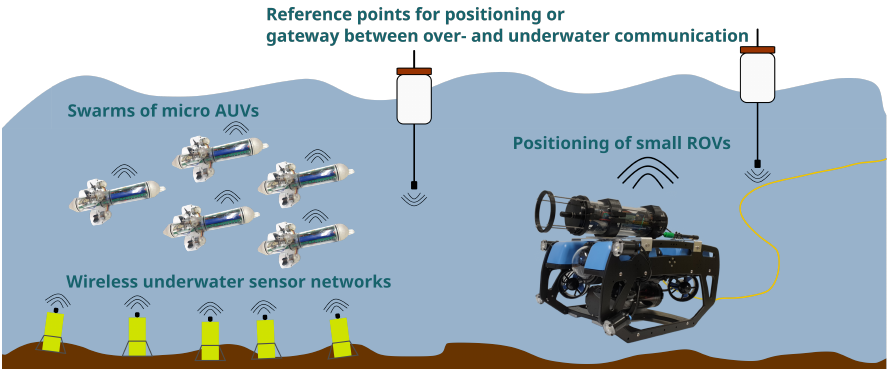
Figure 1. New applications enabled by low-cost underwater modems and positioning systems. Abbreviations: autonomous underwater vehicle (AUV), remotely operated vehicle